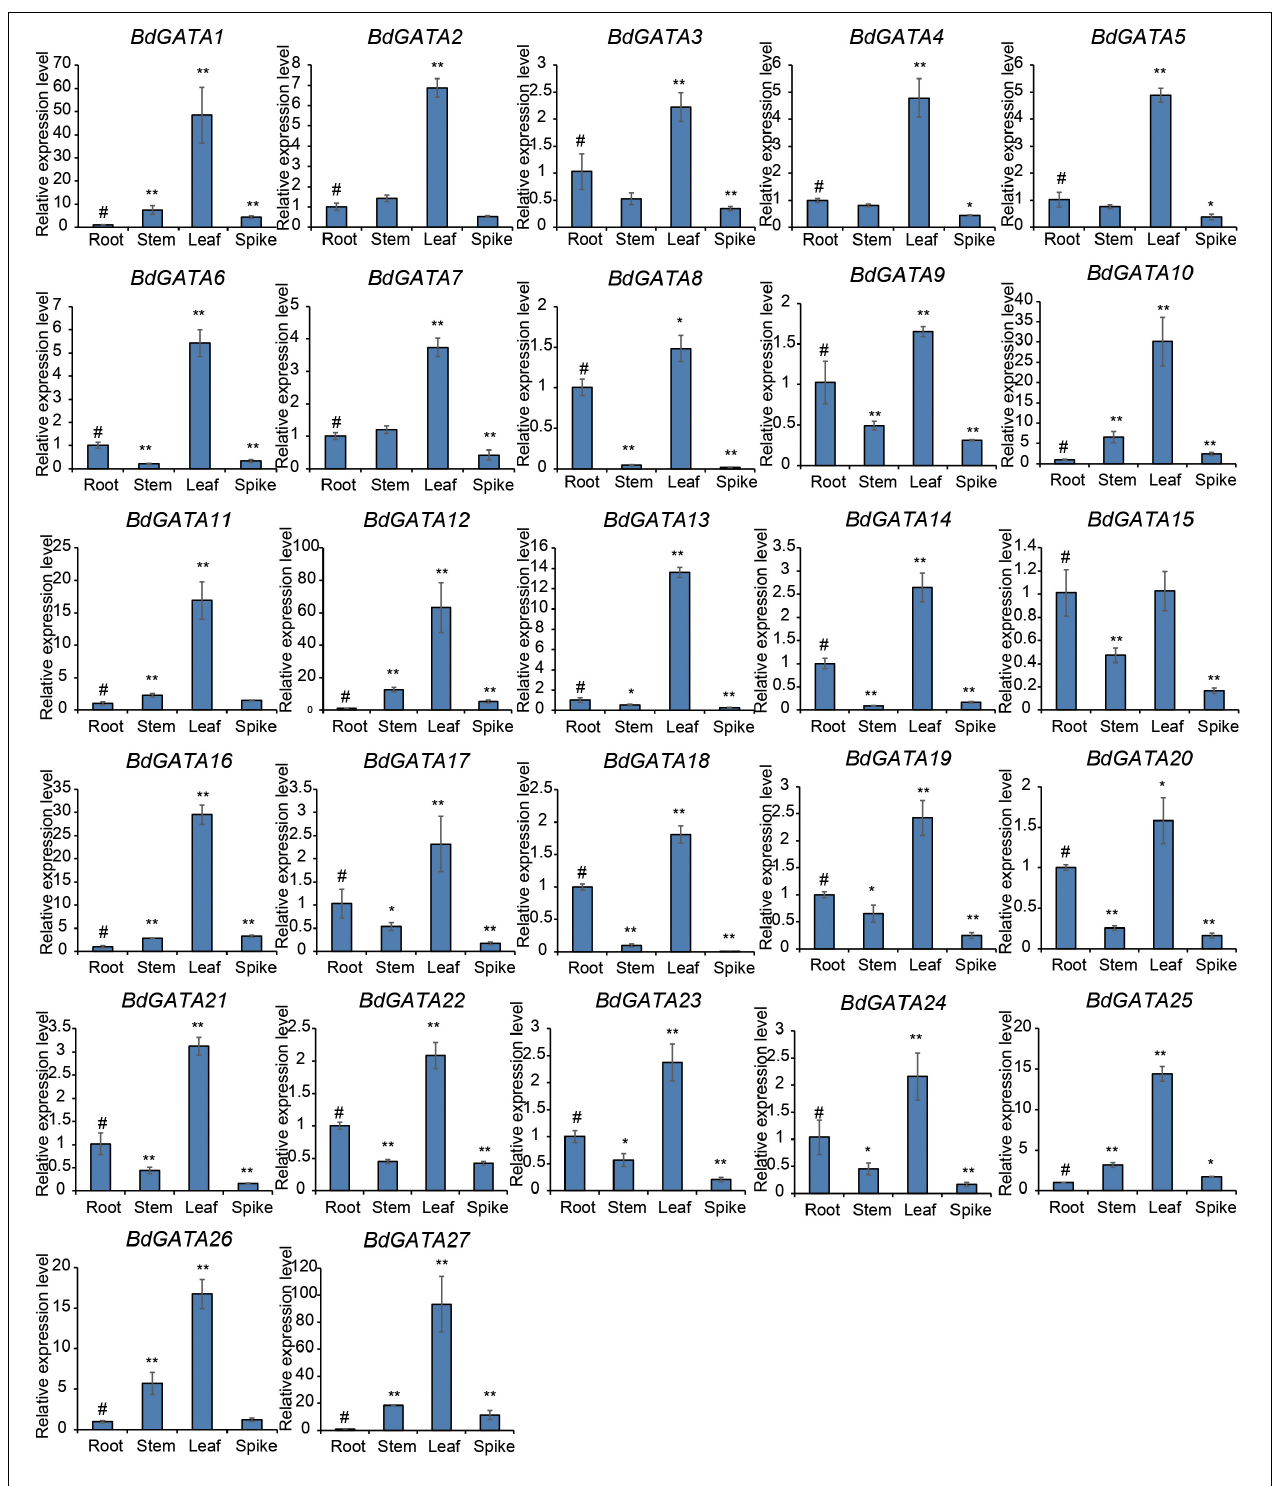
FIGURE 4 | Expression patterns of BdGATAs in different tissues. The ordinate indicates the relative expression level, and the abscissa represents different tissues. The results were normalized against the expression of BdGAPDH as an internal control. Values are means ± SD ( n = 3). Asterisks represent statistically significant differences between the indicated samples. Root (#) is used as control for each tissue. Student’s t -test: * P ≤ 0.05 and ** P ≤ 0.01.